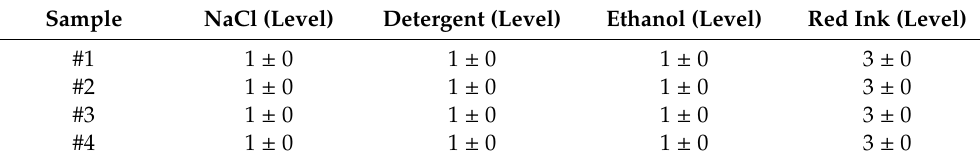
Table 7. The level of waterborne coating after the liquid resistance test. Level Finish Film Change 1 No Mark 2 Slightly Discolored Impression 3 Slight Discoloration or Noticeable Discoloration 4 Obvious Changes, Bubbling, Wrinkles, etc. E ff ect of the coating technologies on the liquid resistance grade of the reversible color-changing